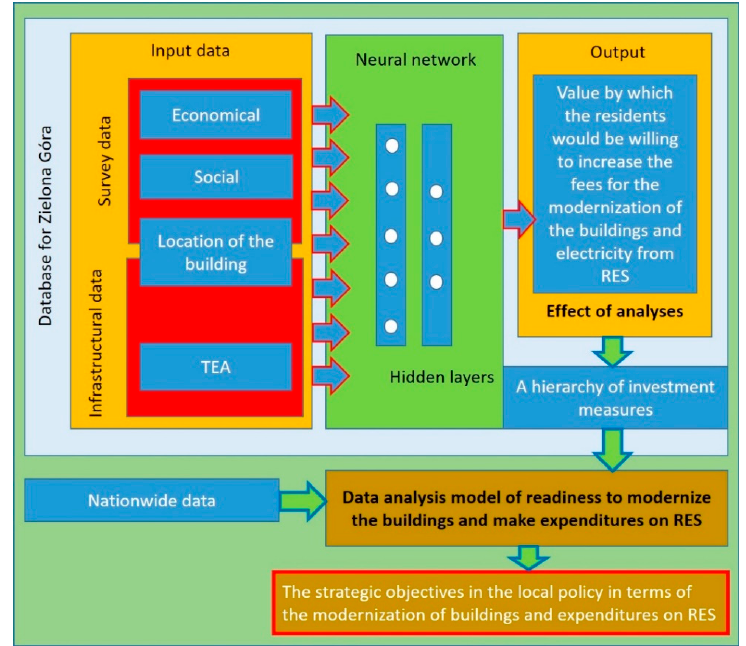
Figure 1. Scheme of modeling the increase in charges for RES energy (Renewable Energy Systems). to local policy using neural